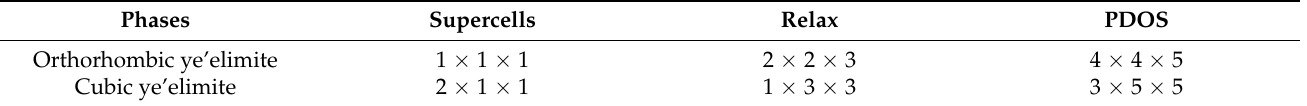
Figure A1. Results of kinetic energy cutoff test and K-points (SS). Structure of SS was selected to conduct the kinetic energy cutoff test and K-points test, as the structure contains all pseudopotentials. Table A1. K-point grids for simulation models.